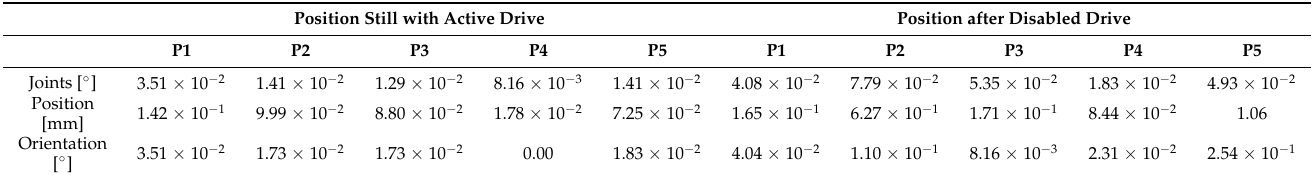
Table 4. Root mean square error (RMSE) associated with test no. 2.